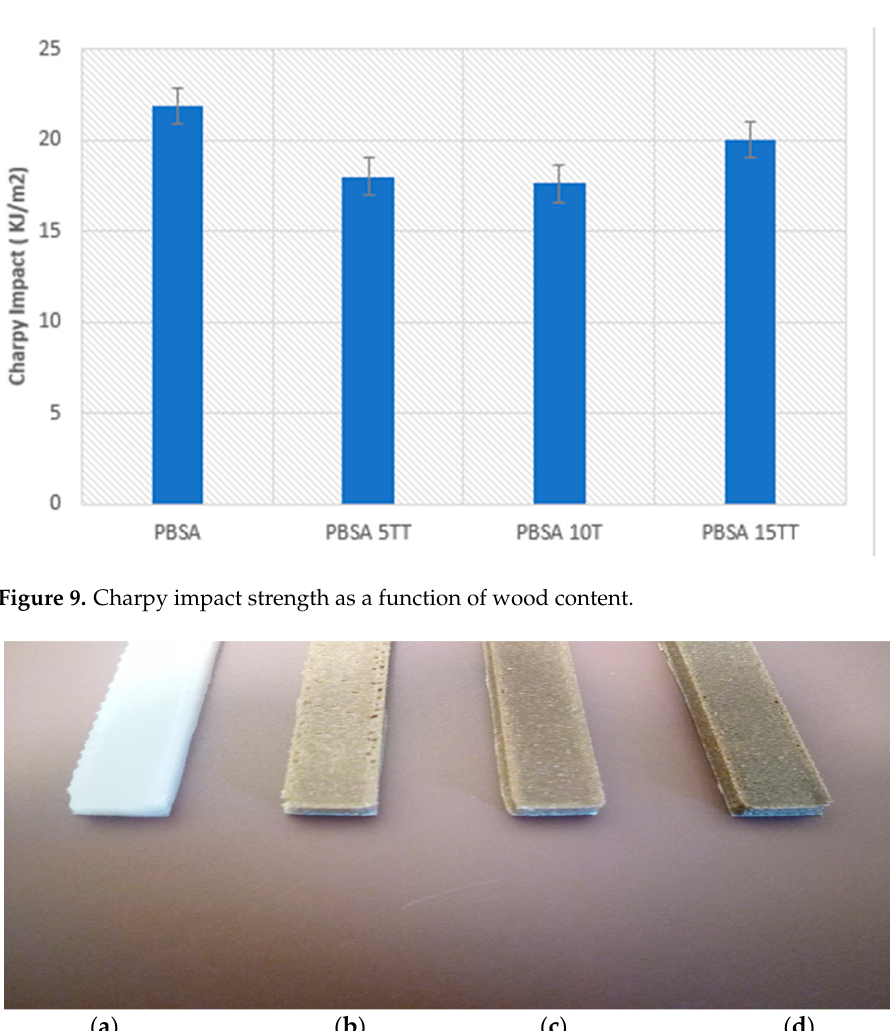
( B ) Figure 8. Cubic geometry of Typha-PBSA biocomposite. 3.4. Charpy Impact Tests The results of the Izod impact test are presented in Figure 9. A decrease in the impact resistance of pure PBSA is observed with increasing the content of Typha stem fibres up to 5% Typha stem powder in the biomaterials. Indeed, this slight decrease is already re- ported for lignocellulosic fibre-reinforced polymer composites [28]. The mechanisms of impact energy absorption by the fibres are threefold, i.e., unbinding, tearing, and fracture, but due to the direction of printing and the screen angle of the fused deposition method, there is a good dispersion and distribution of the fibres in the polymer matrix and a de- crease in absorption energy. This adhesion between the matrix and the fibre predisposes the material to a lower energy absorption. This leads to an improvement in the mechanical properties of the biomaterial. At 10% Typha stem fibre, the impact energy of the fibres